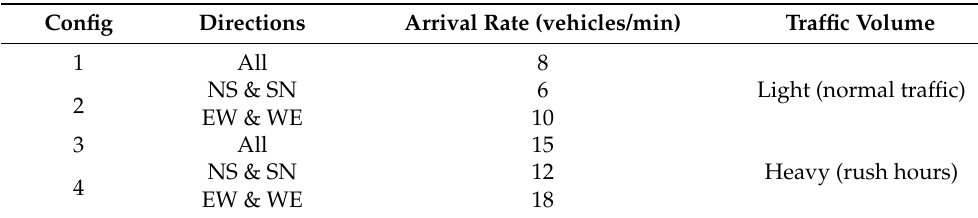
Table 1. Various configurations of synthetic dataset.